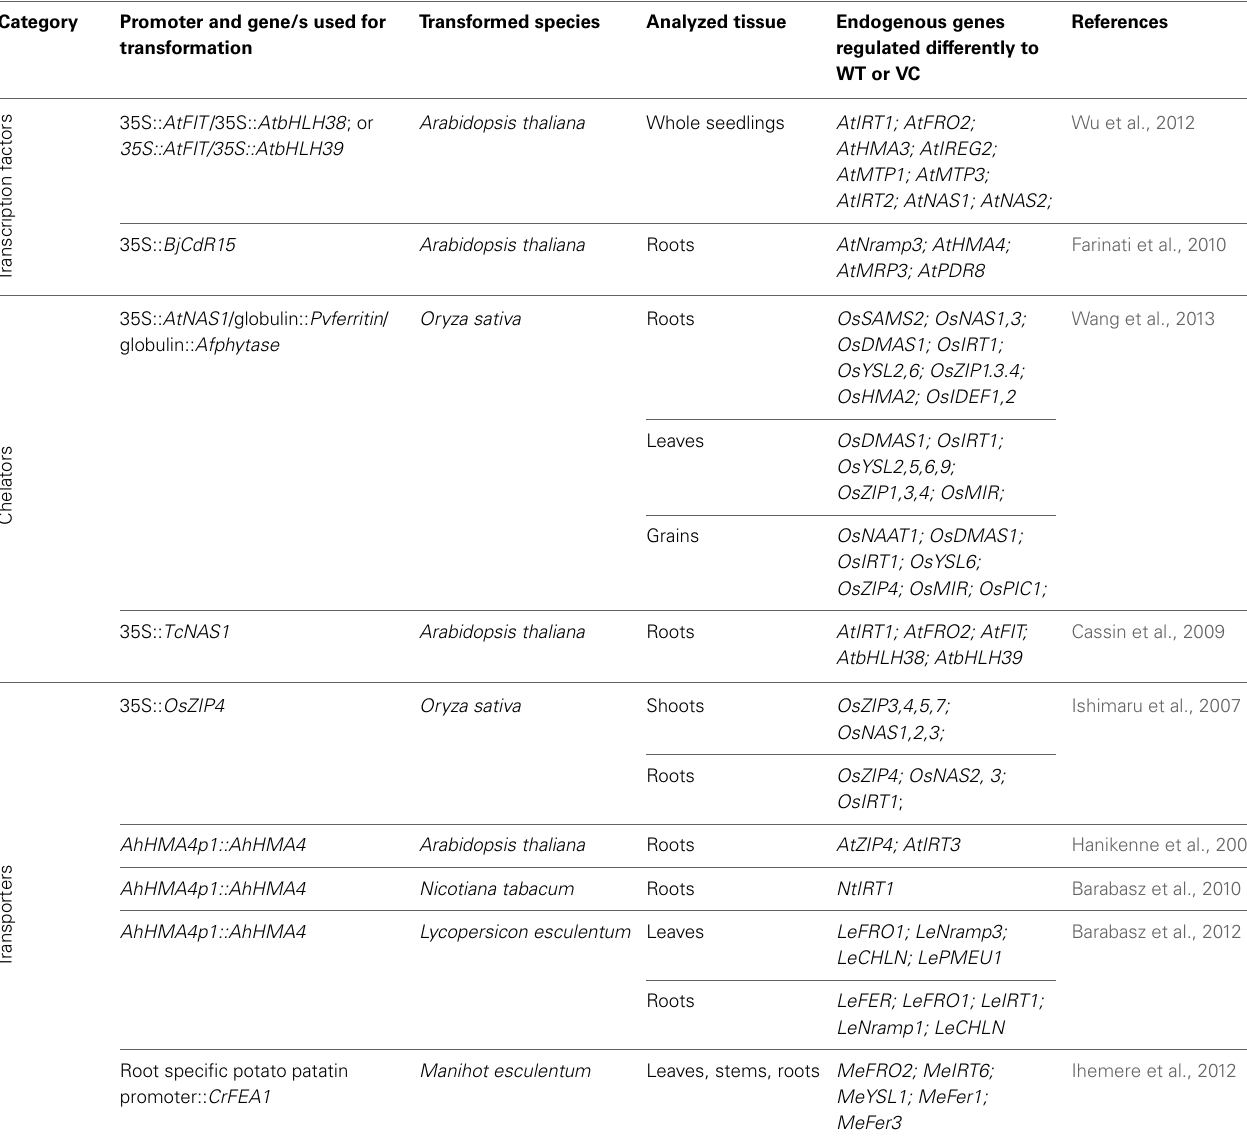
Table 1 | List of transformations discussed in the review; shown are the genes and species used for transformation, and identified metal-homeostasis genes differentially expressed in transformants relative to wild-type (WT) or vector-controls (VC).